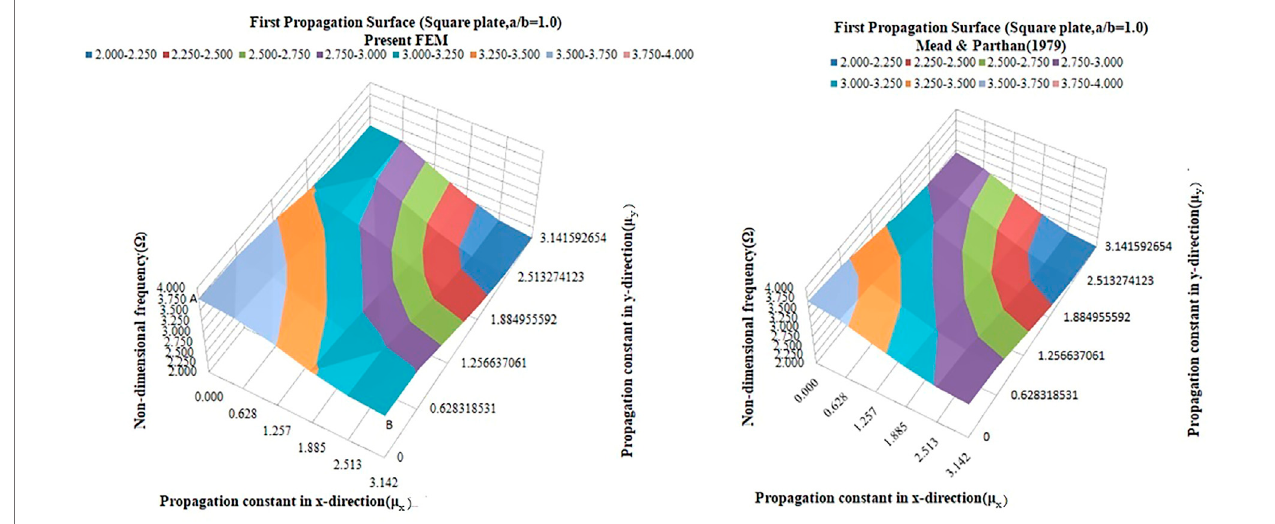
FIGURE 6 | Comparison of the present propagation surface of the periodic square plate using PS-FEM with (Mead and Parthan, 1979).